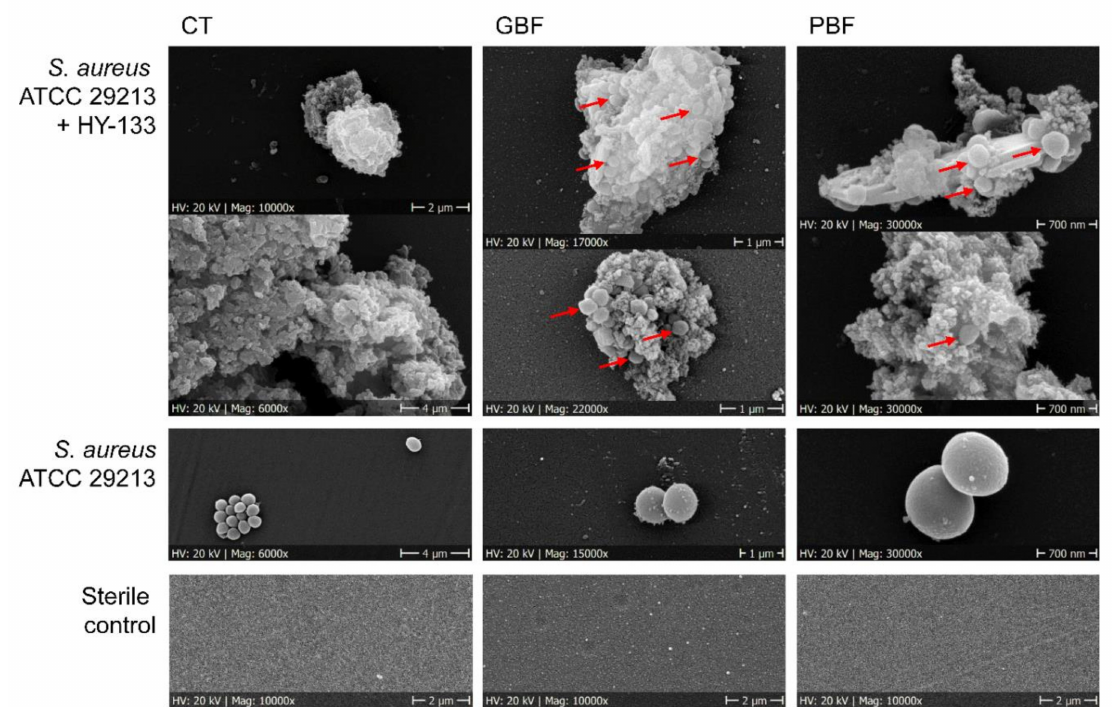
Figure 6. Scanning electron microscopic analysis of the impact of different culture flask materials on the in vitro stability and activity of HY-133 against S. aureus strain ATCC 29213. Red arrows mark S. aureus cells enclosed in agglomerates of inactive enzyme. Magnifications are provided below each picture. CT, centrifuge tube; GBF, glass baffled flask; PBF, plastic baffled